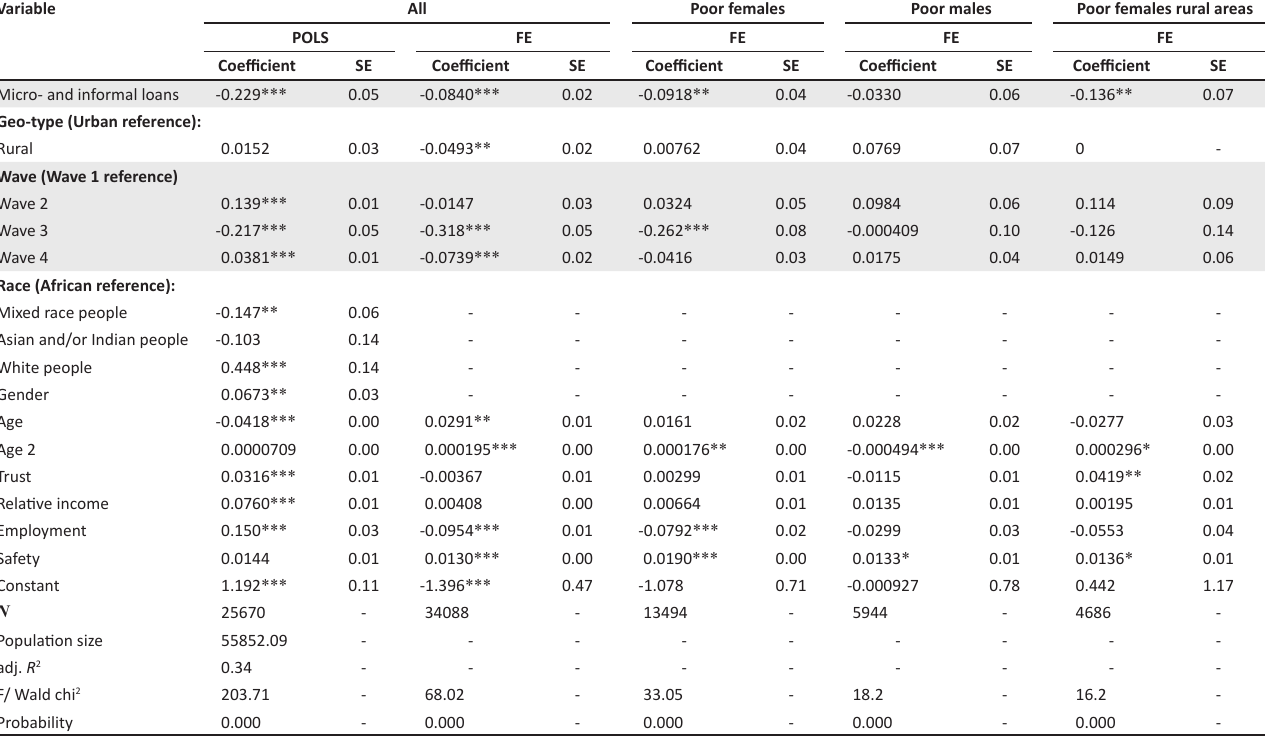
TABLE 4: Estimation results of pooled ordinary least squares and fixed effect for the whole sample and sub-samples ‘poor females’, ‘poor males’ and ‘poor females in rural areas’ (income-independent quality of life = dependent variable). Variable